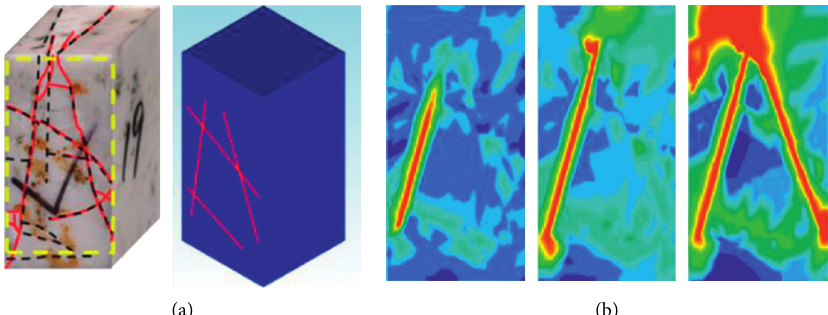
Figure 15: (a) The numerical and experimental failure modes of specimens and (b) crack evolution in specimens containing multiple parallel